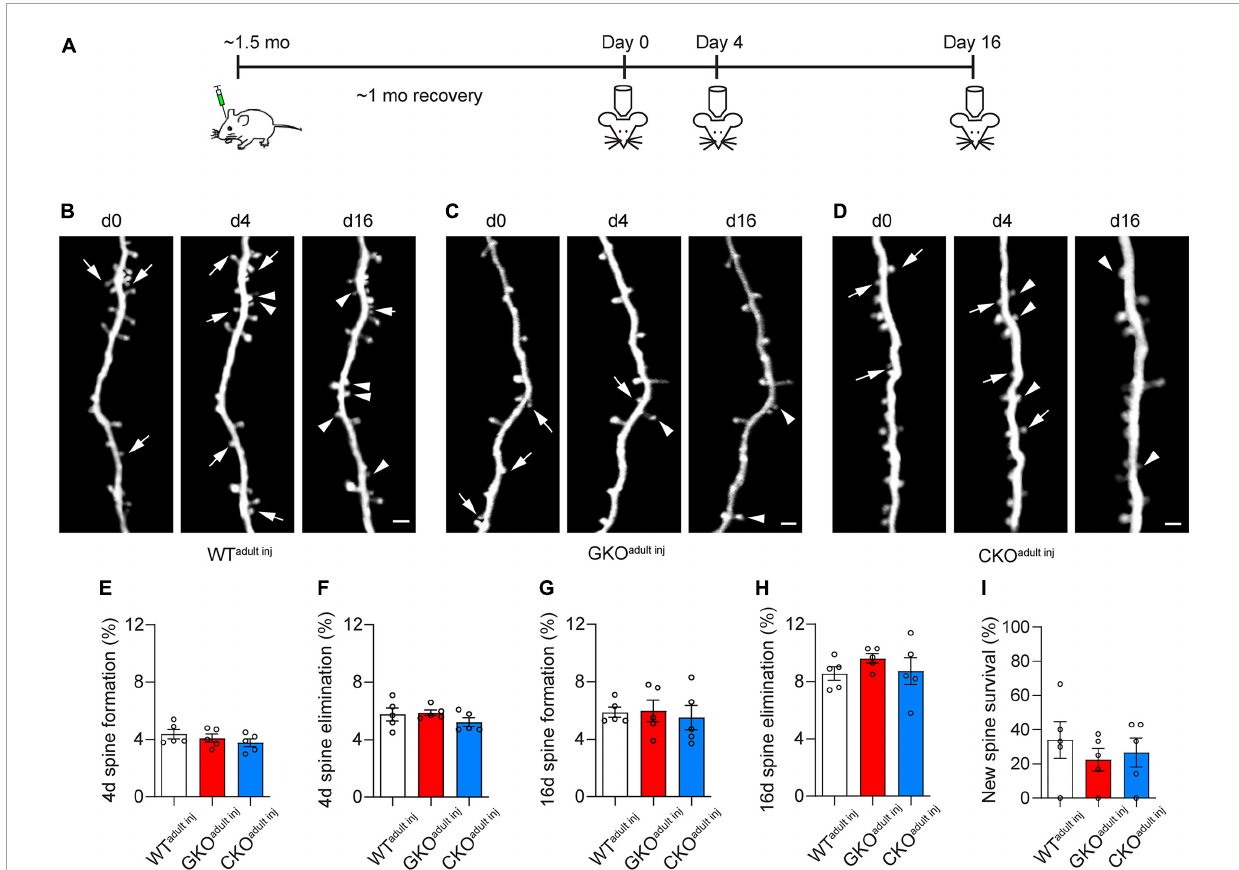
FIGURE3 Cell-autonomous Fmr1 knockout (KO) in adulthood does not affect spine formation or elimination. (A) Timeline of virus injection and in vivo two-photon imaging. (B–D) Examples of spine formation and elimination in WT adult inj (B) , global knockout (GKO adult inj ) (C) , and conditional knockout (CKO adult inj ) (D) mice. Arrows: eliminated spines; arrowheads: formed spines. Scale bar = 2 µ m. (E,F) Spine formation (E) and elimination (F) rates over 4 days in WT adult inj , GKO adult inj , and CKO adult inj mice. (G,H) Spine formation (G) and elimination (H) rates over 16 days in WT adult inj , GKO adult inj , and CKO adult inj mice. (I) Percentage of new spines formed by day 4 that survived till day 16. n = 5 mice per